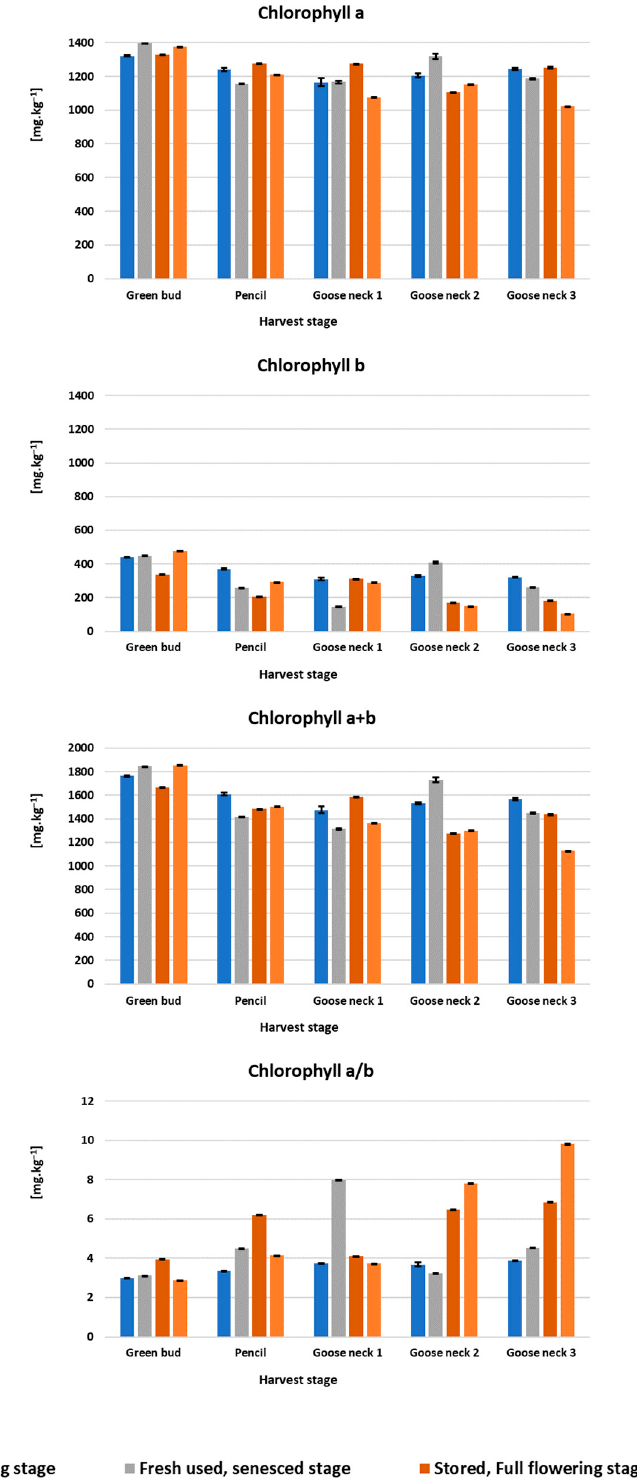
Figure 14. Chlorophyll content of the scapes. Bud stages: green bud (GB); pencil: white bud, upright (PE); goose neck 1: white bud, skew (GN1); goose neck 2: white bud, horizontal (GN2); goose neck 3: big white bud, horizontal, maximum with 1 opening petal (GN3).